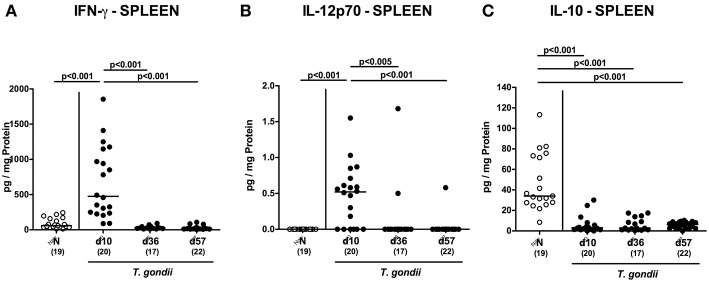
Splenic inflammatory mediator secretion over time following peroral low-dose T. gondii infection. Mice were perorally infected with one cyst of T. gondii on day 0 and surveyed at days (d) 10, 36, and 57 post-infection (p.i.; closed circles). Naive (N) mice served as uninfected controls (open circles). (A) IFN-γ, (B) IL-12p70, and (C) IL-10 concentrations were measured in ex vivo biopsies taken from the spleen at respective time points. Medians (black bars), levels of significance (p-values) as determined by one-way ANOVA test followed by Tukey post-correction for multiple comparisons and numbers of analyzed mice (in parentheses) are indicated. Data were pooled from four independent experiments.